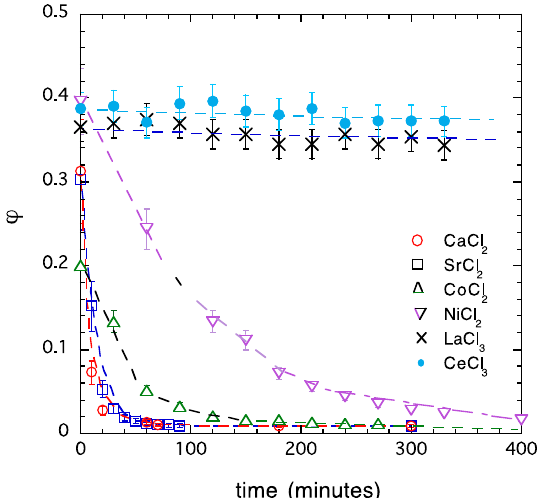
Figure 8. Kinetics of reswelling of PA gels deswollen in multivalent salt solutions. The gels were immersed in 40 mM NaCl